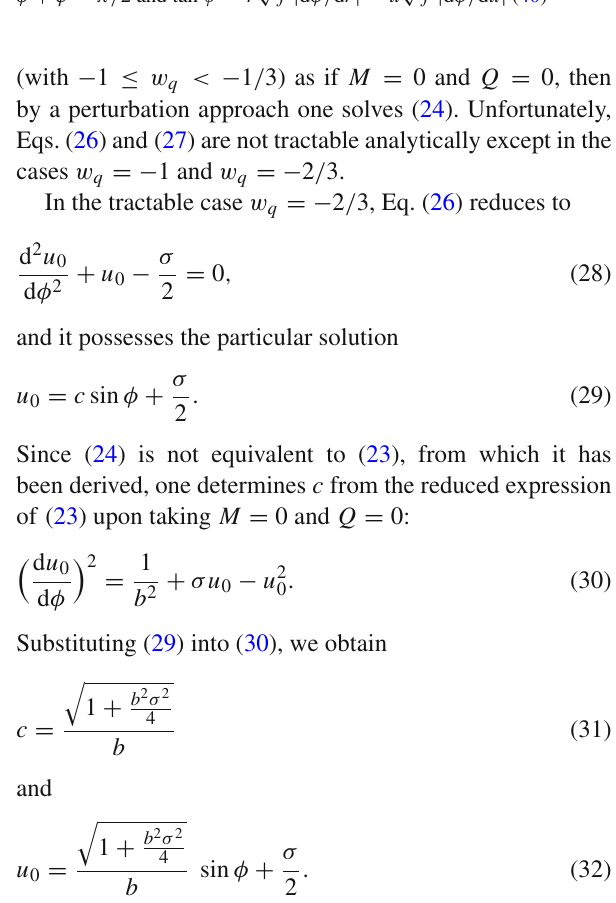
Fig. 4 The diagram shows the real curved path the photons follow versus the fictitious free straight path they would follow in empty space if carrying the same angular momentum L and same energy E . Here √ √ φ + ϕ = π/ 2 and tan ψ = r f | d φ/ d r | = u f | d φ/ d u | (40)